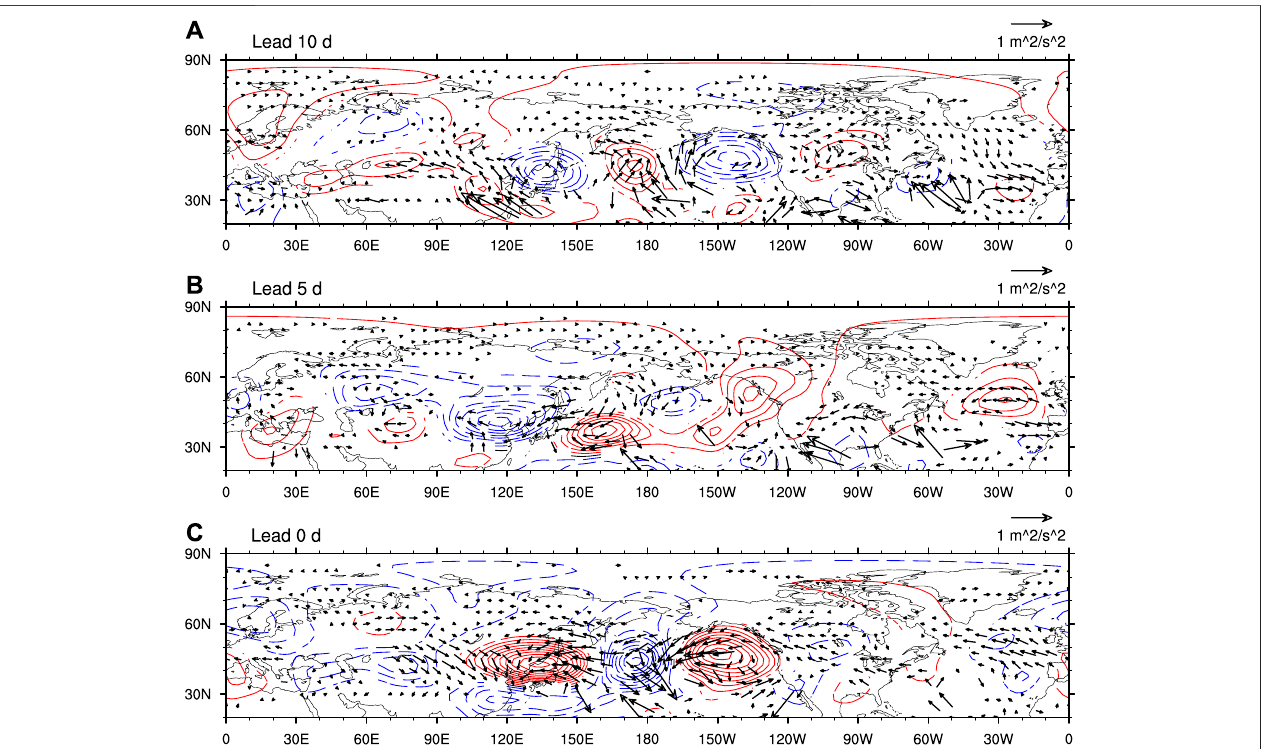
FIGURE 5 | As in Figure 3 , but for stream functions (shaded, unit: 10 – 6 m 2 s − 1 ) and wave activity fl ux (vectors, unit: m 2 s − 2 ) at 200 hPa.